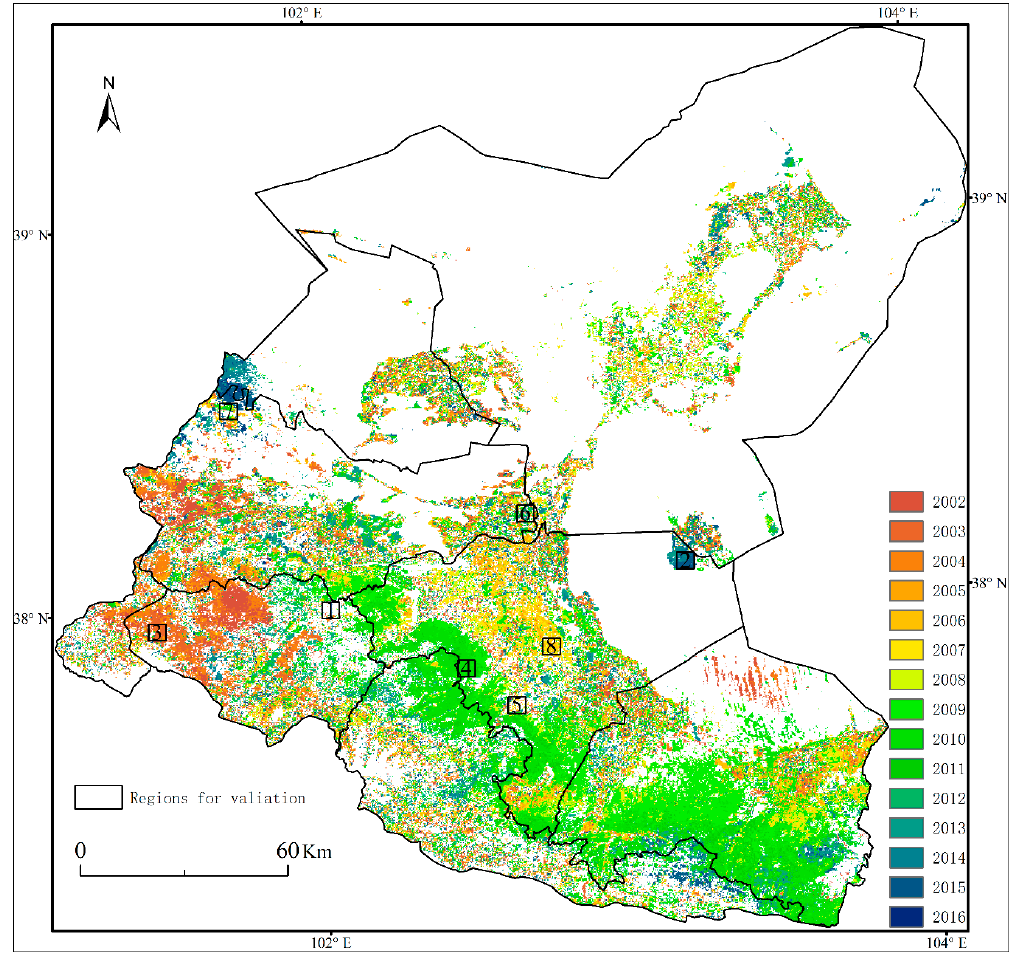
Figure 4. The transition years of the exponential pattern and the logarithmic pattern which have only one transition years during the observation period, and the first transition year of the logistic pattern.